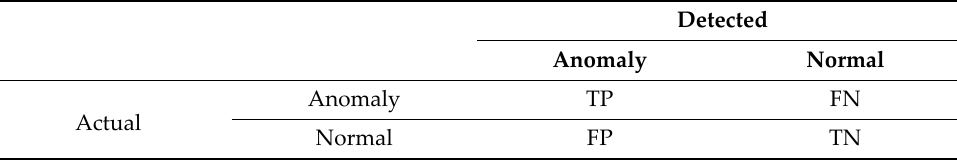
Table 4. Confusion matrix of anomaly detection evaluation